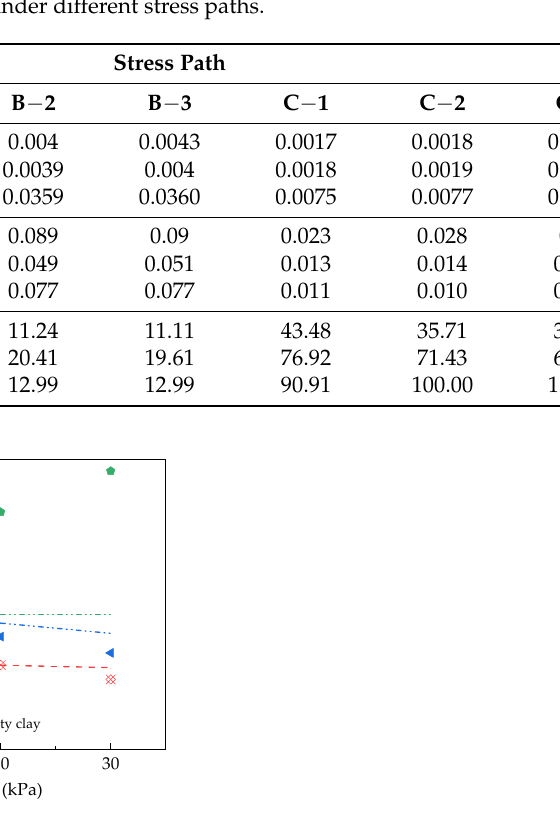
Figure 9. Normalized initial elastic modulus–unloading intensity relationship under different stress paths.